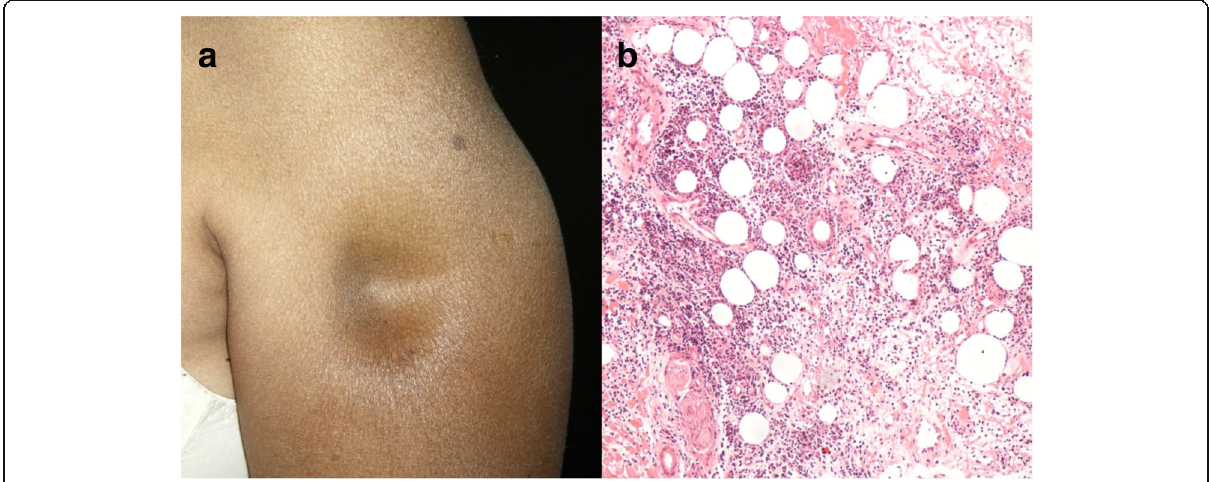
Fig. 6 Lupus panniculitis. a Depressed area involving the proximal part of the arm. b Extensive lobular infiltrate composed of lymphocytes. H&E,